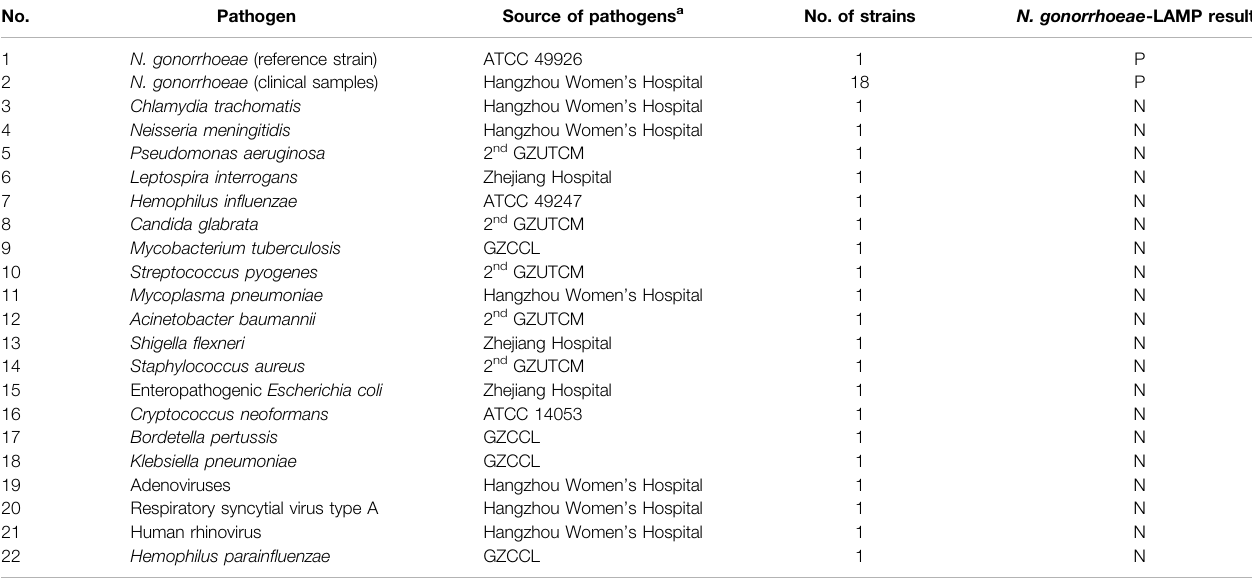
TABLE 2 | Pathogens used in the current